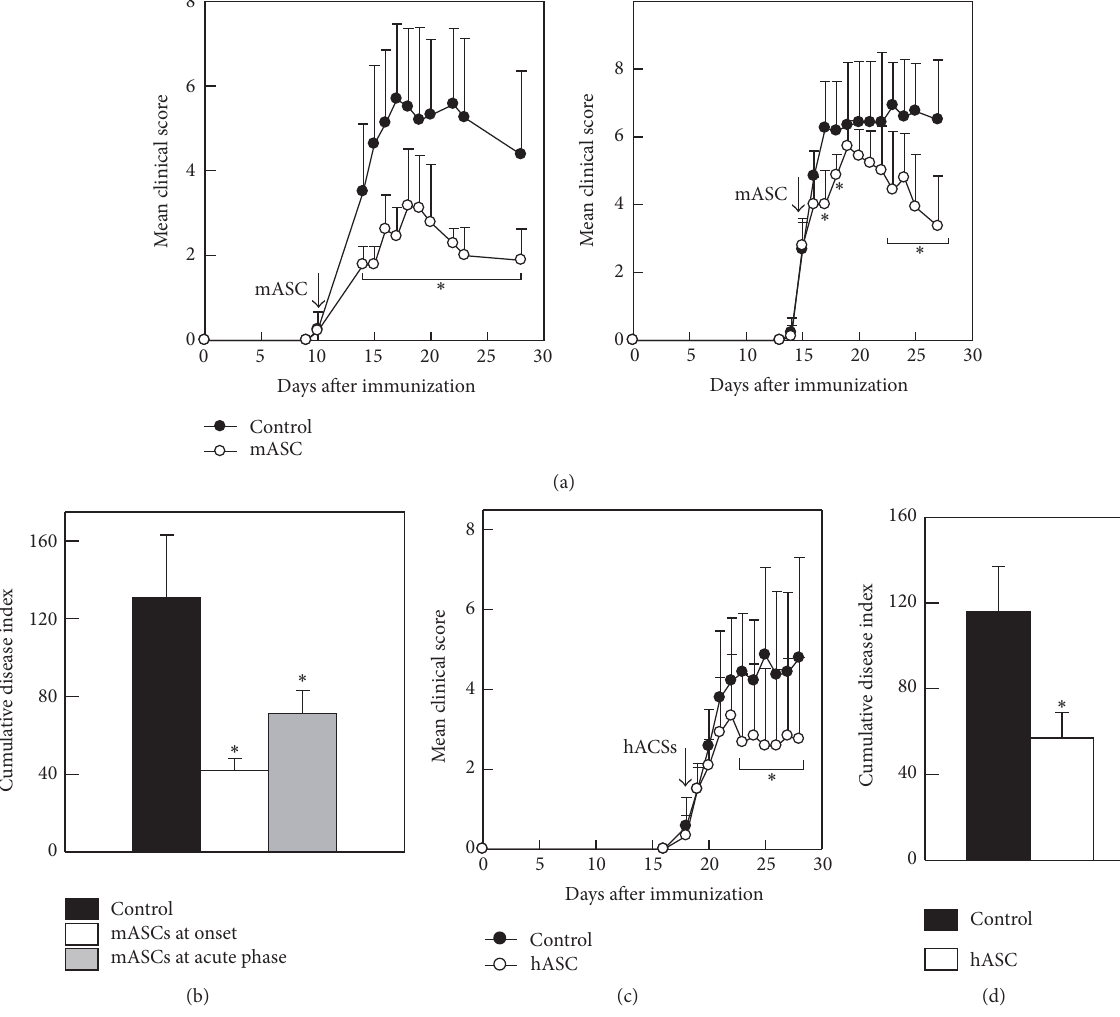
Figure 2: Allogeneic and xenogeneic ASC reduce EAE severity. Chronic progressive EAE was induced in C57Bl/6 mice by immunization with MOG 35−55 . Animals were injected intraperitoneally with PBS (control) or with hypoxia-expanded allogeneic mASCs (10 6 cells/mouse) either at the onset of EAE (day 11 after immunization) when the mean clinical score was 0.25 in the control group ( 𝑛 = 8 mice) and 0.22 in the mASC-treated group ( 𝑛 = 9 mice) or at the acute phase of EAE (day 15 after immunization) when the mean clinical score was 2.7 in the control group ( 𝑛 = 6 mice) and 2.8 in the mASC-treated group ( 𝑛 = 7 mice). (a) Clinical symptoms were scored daily in the group treated at onset (left panel) and at the acute phase of EAE (right panel). (b) Cumulative disease index is the sum of daily clinical scores observed between days 20 and 40. Results are shown as mean (SD). ∗ 𝑝 < 0.05 versus control. (c) Human ASCs ameliorate EAE. Mice with MOG-induced EAE were intraperitoneally injected with PBS (control, 𝑛 = 7 ) or with hASCs expanded in hypoxia (10 6 cells/mouse, 𝑛 = 6 mice) during the acute phase of the disease (arrow) when the mean clinical score was 1.5 in both groups. Clinical symptoms were scored daily. (d) Cumulative disease index is the sum of daily clinical scores observed between days 20 and 40. Results are shown as mean (SD). ∗ 𝑝 < 0.05 versus